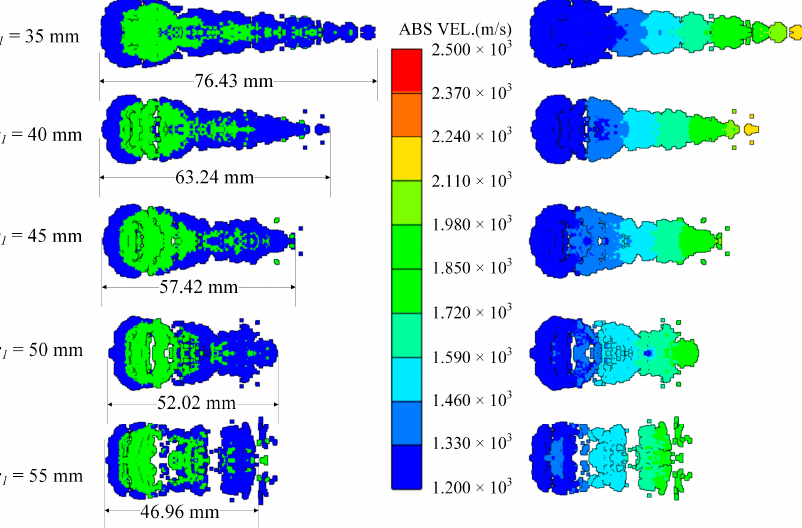
Figure 12. Coating shapes and velocity distribution as the curvature radius of the copper liner changes.